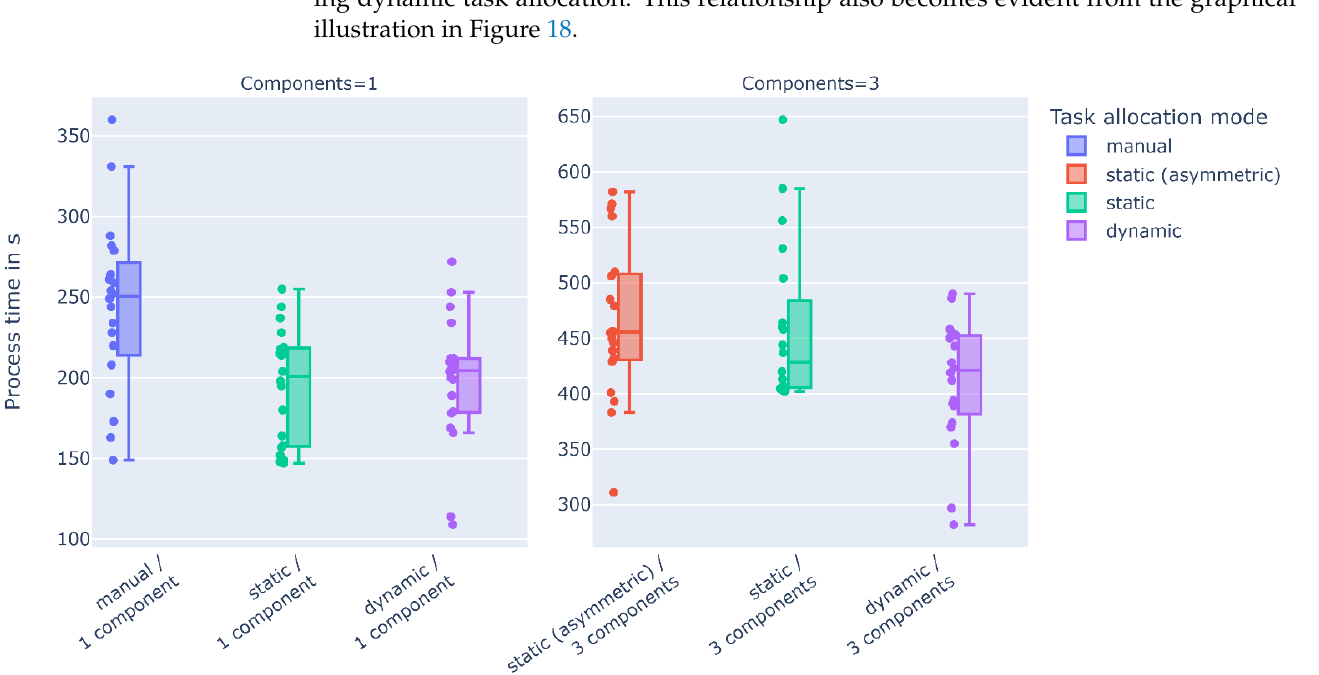
Table 4. Overview of mean process times per task allocation mode and duration of the delay. The task allocation mode with minimum process time is highlighted in bold for each setting.